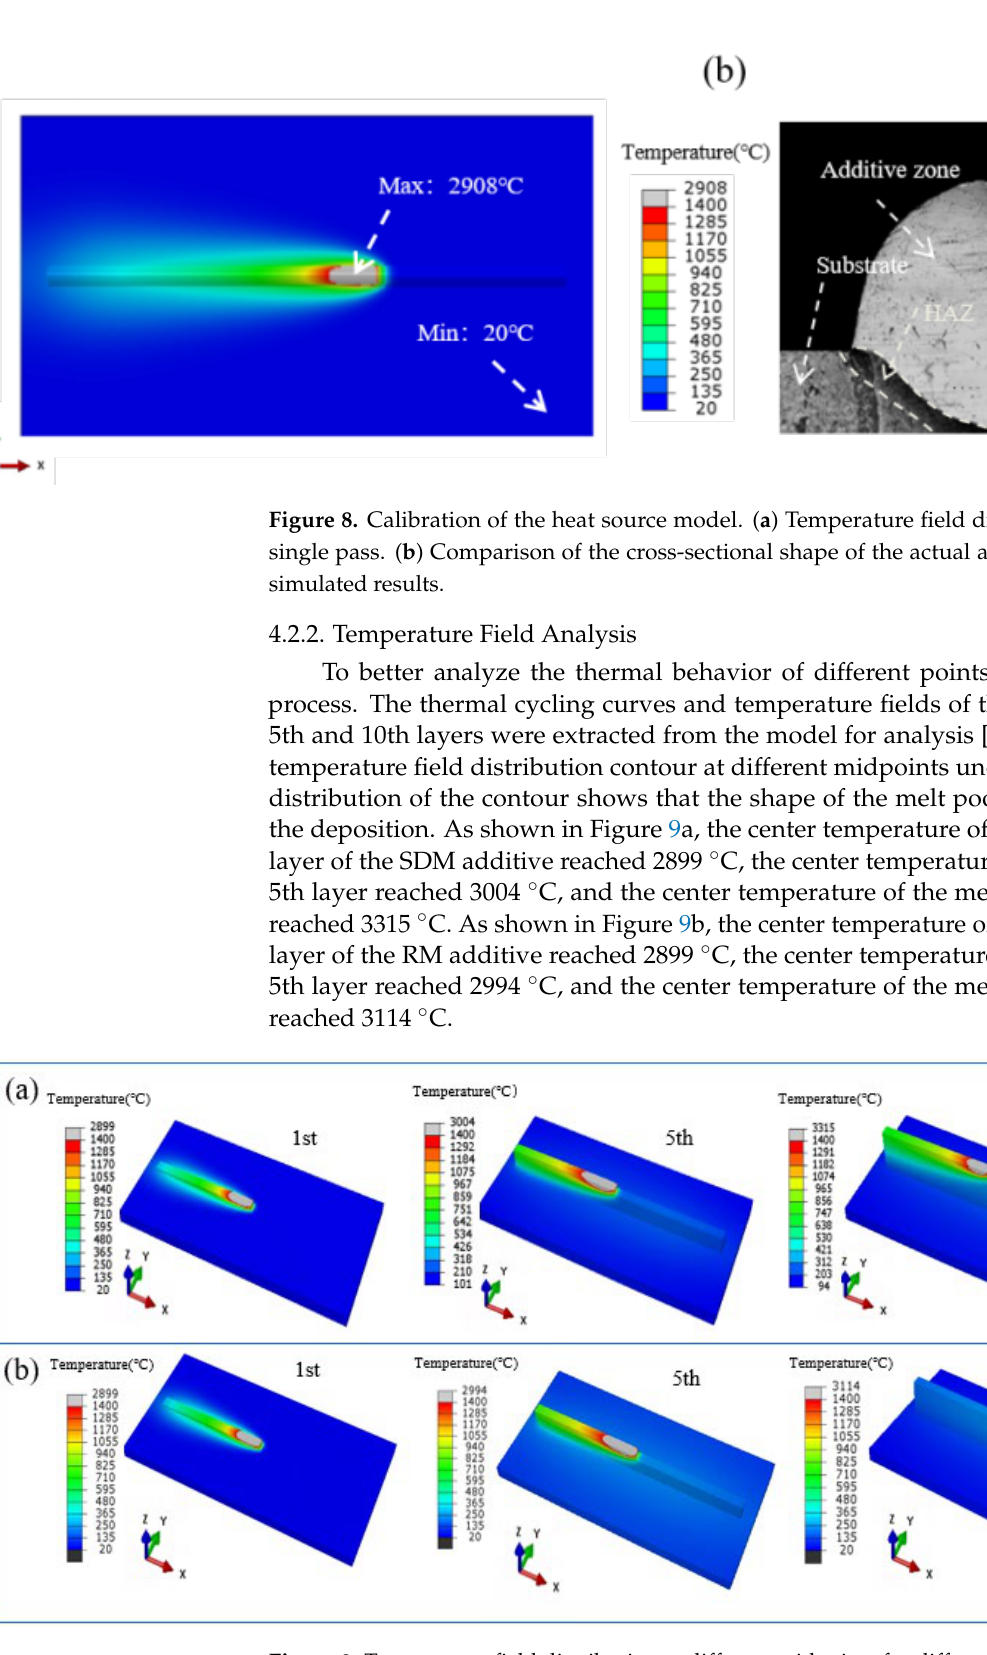
10 of 17 Figure 7. Microstructure of 2205 duplex stainless steel by WAAM. ( a , b ) Microstructure at the bottom along BD direction. ( c , d ) Microstructure in the middle along BD direction. ( e , f ) Upper microstruc- ture along BD direction. 4.2. Simulation Result Analysis 4.2.1. Calibration of the Finite Element Model In this paper, the heat source model was first calibrated and the deposition of mono- layer single-pass was carried out by the CMT wire and arc additive manufacturing pro- cess, using the same process parameters as in Section 2. After the monolayer single-pass AM testing, the morphology of the monolayer single-pass cross-section was observed un- der an inverted optical microscope (IOM). The temperature field of the monolayer single-